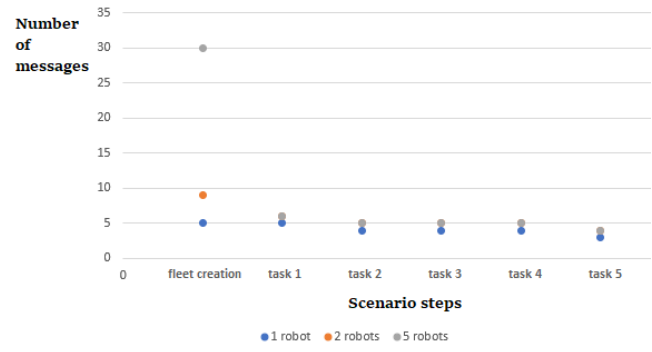
Figure 13. Message distribution